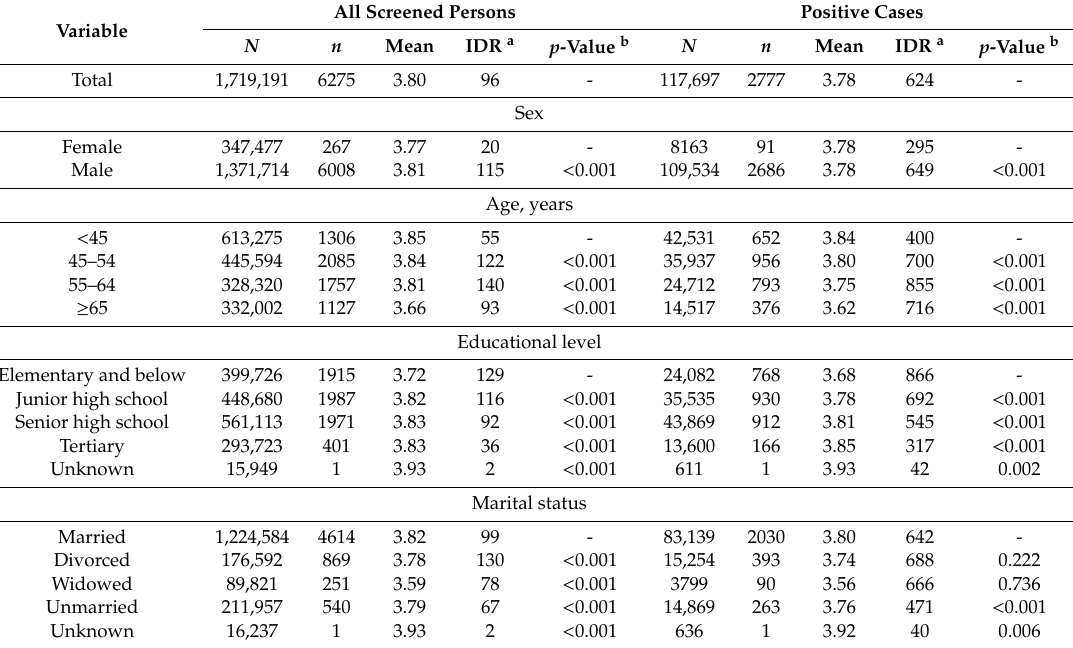
Table 1. Basic information and rate of oral cancer incidence in the high-risk population screened for oral